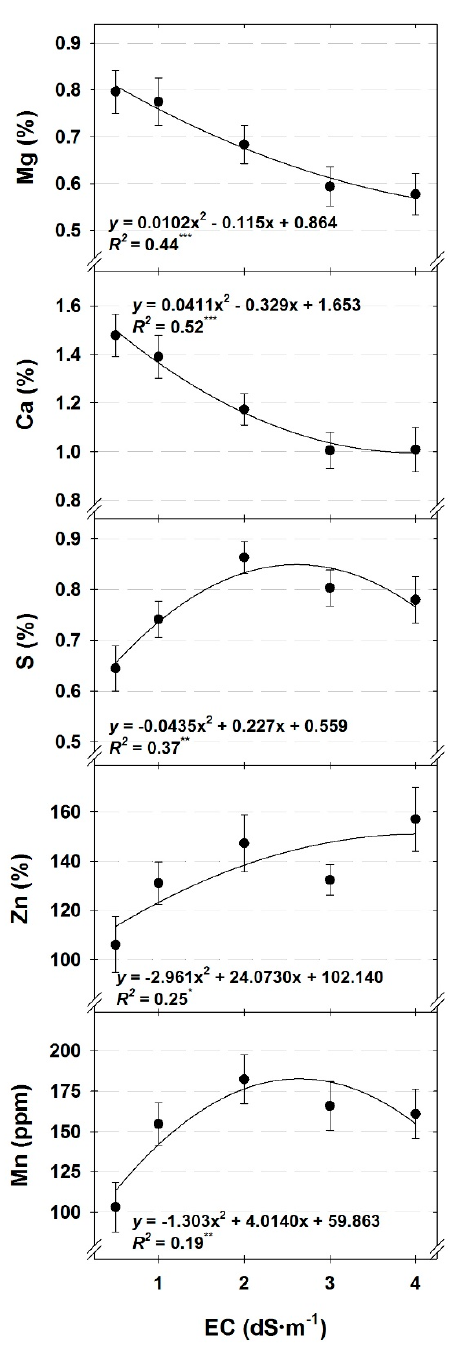
Figure 3. Tissue K, Mg, Ca, S, Zn, and Mn of dill ( Anethum graveolens ‘Fernleaf’) 4 weeks after transplanting into nutrient-film technique hydroponic systems in a greenhouse under a low (~7 mol · m − 2 · d − 1 ) or high (~18 mol · m − 2 · d − 1 ) daily light integral (DLI) with a range of nutrient solution electrical conductivity (EC; 0.5 to 4.0 dS · m − 1 ) treatments. Data were pooled across daily light integrals within EC. Each symbol represents the mean of six replications with ten plants per replicate, and error bars represent the standard errors of the mean of the six replicates. *, **, or *** indicate significant at p ≤ 0.05, 0.01, or 0.001, respectively.